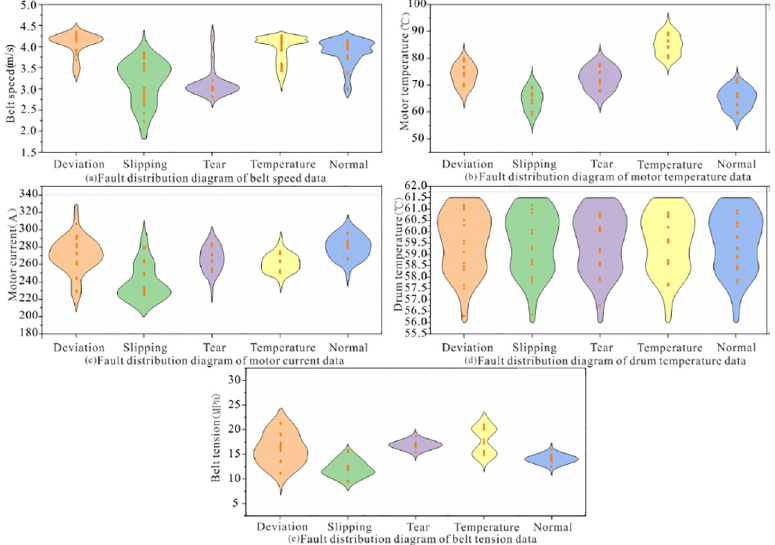
Fig 1. Data distribution. (a) Fault distribution diagram of belt speed data, (b) Fault distribution diagram of motor temperature data, (c) Fault distribution diagram of motor current data, (d) Fault distribution diagram of drum temperature data, and (e) Fault distribution diagram of belt tension